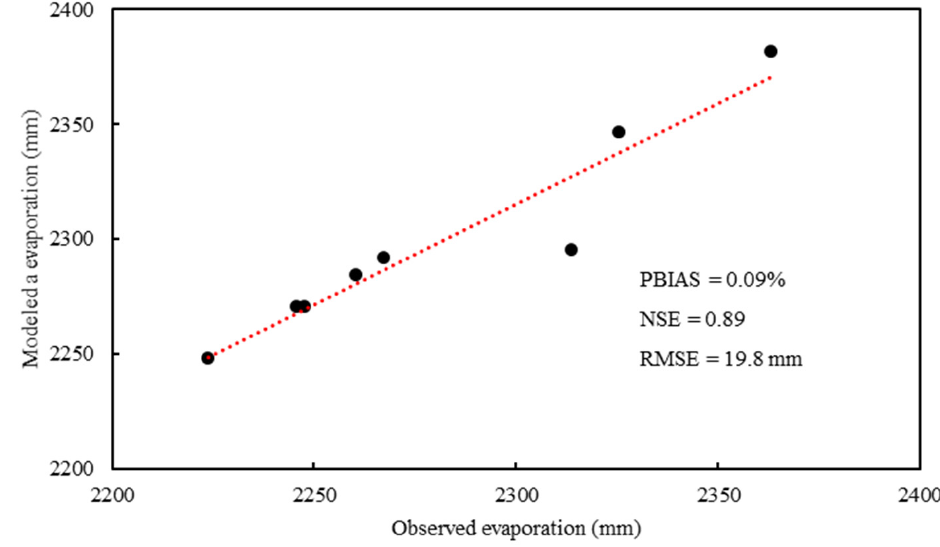
Figure 4. Observed and modeled average annual evaporation.